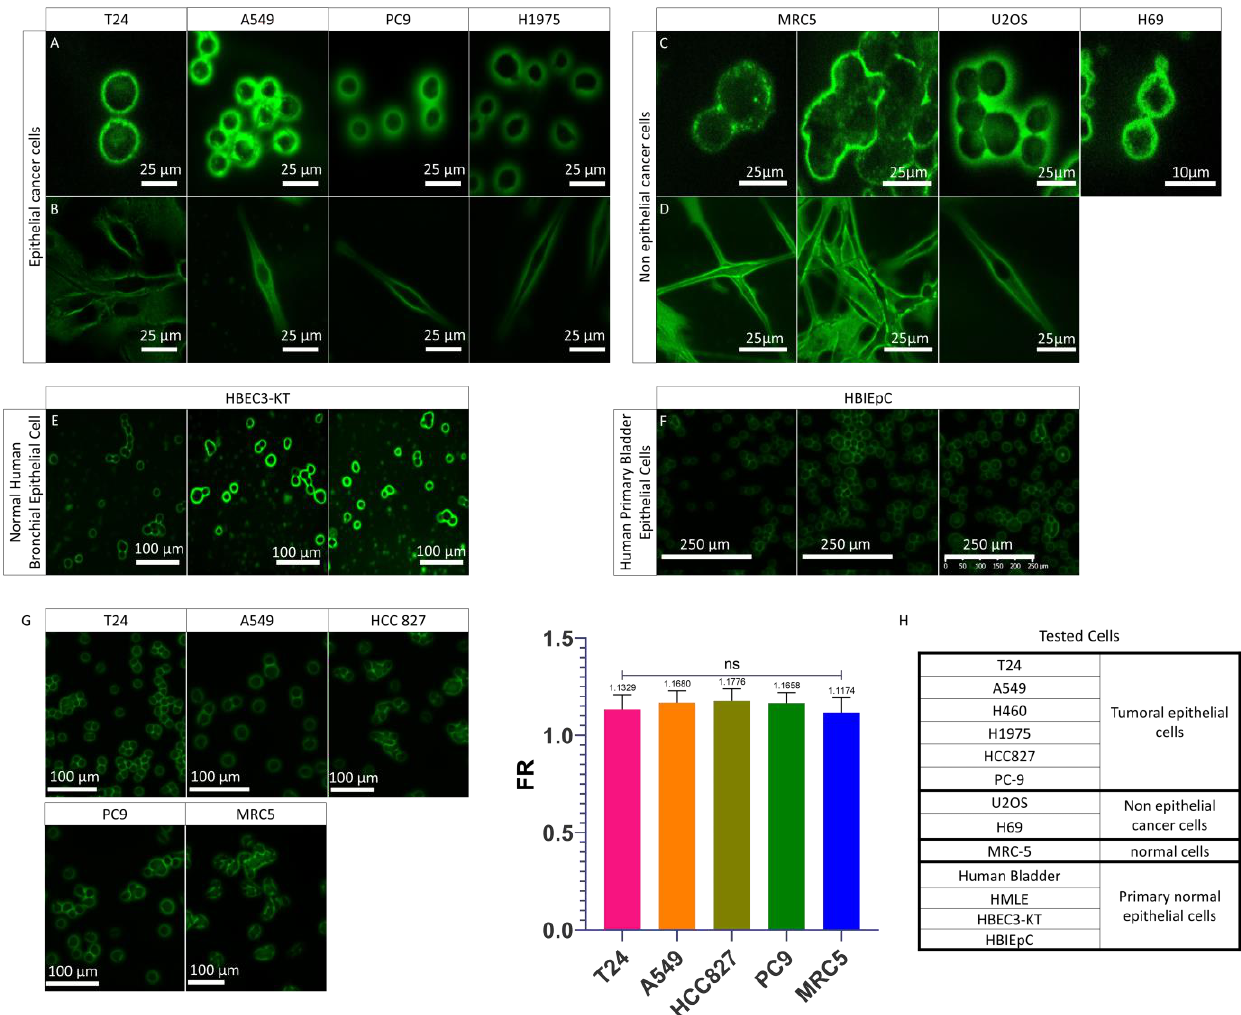
Figure 2. PMF on different cells line. ( A ) Images acquired on confocal microscope of epithelial cancer cell lines in suspension mounted on the slide as a urinary cytology. ( B ) Z-stack images ac-quired on confocal microscope of adherent epithelial cancer cell lines mounted on slide as urinary cytology. ( C ) Images acquired on confocal microscope of non-epithelial cell lines in suspensions mounted on slide as urinary cytology. ( D ) Z-stack images acquired on confocal microscope of adherent non- epithelial cell lines mounted on slide as urinary cytology. ( E ) Images acquired on the scanner of a normal human bronchial epithelial cell line. ( F ) Images acquired on the scanner of a normal human primary bladder epithelial cell line. ( G ) Images acquired on the scanner on previously tested cell lines and quantification of their PMF with FR. Bar graphs represent the mean (SD) (ns > 0.05). ( H ) Origins of tested cells showing PMF.